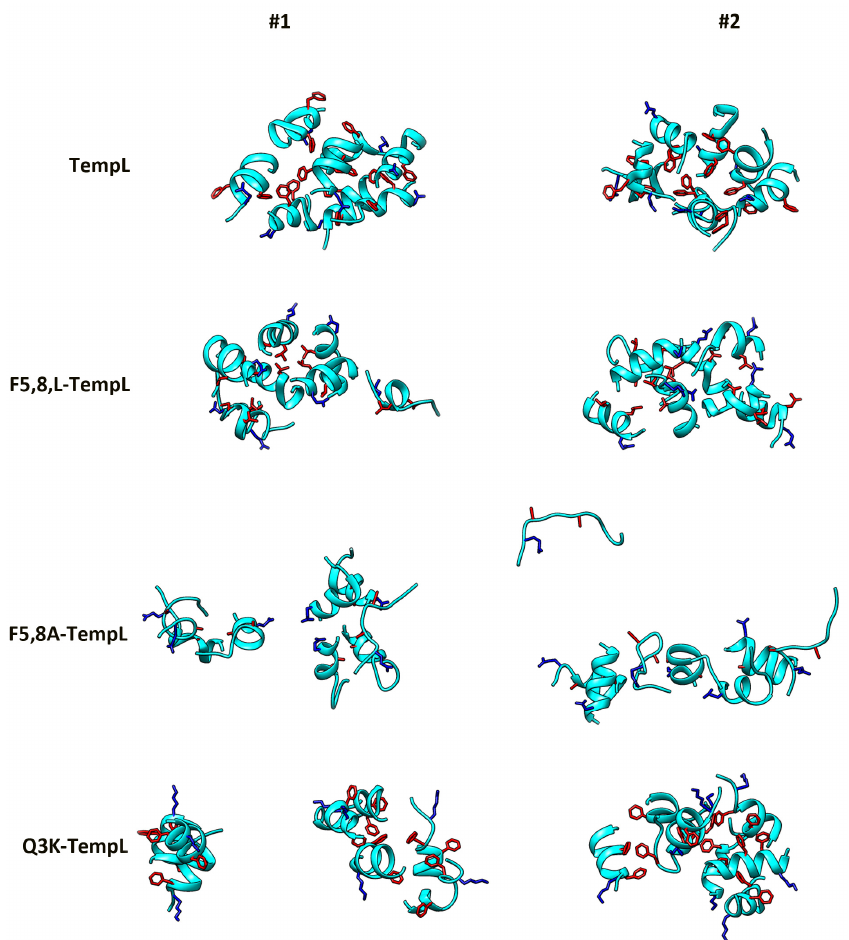
Figure 1. Final structures of the MD simulations in water. For each peptide (TempL, F5,8L-TempL, F5,8A-TempL and Q3K-TempL from the top) the structures from two independent simulations are reported. Peptides are represented as cyan ribbon; and residues 3, 5 and 8 are reported in stick representation (blue for Q/K residues at position 3 and red for the F/L/A at positions 5 and 8). Table 2. MD simulations in water. The reported parameters have been evaluated in the last 5 ns of the simulations, as average of two independent simulations.